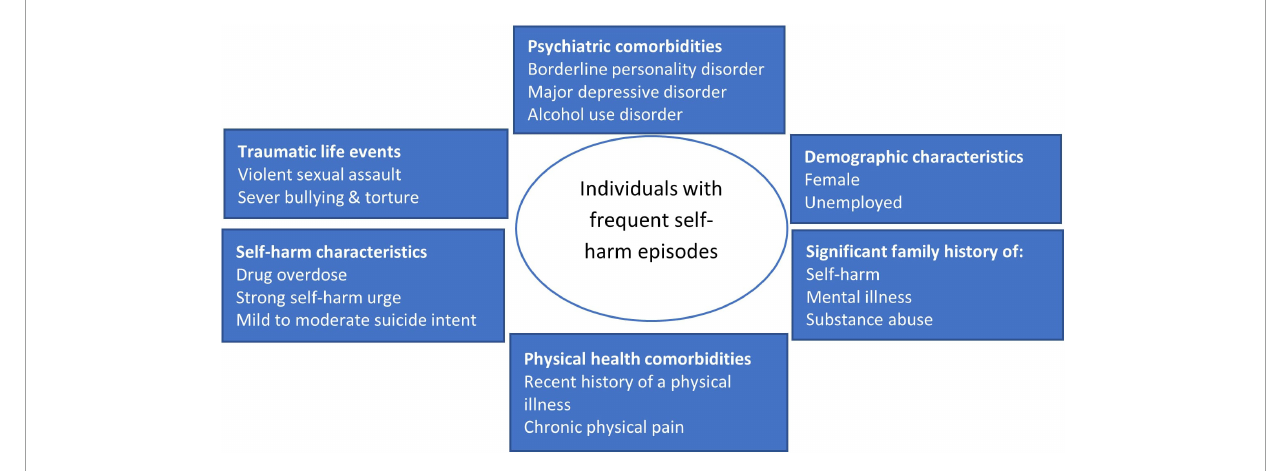
FIGURE3 Key profile of individuals with frequent self-harm